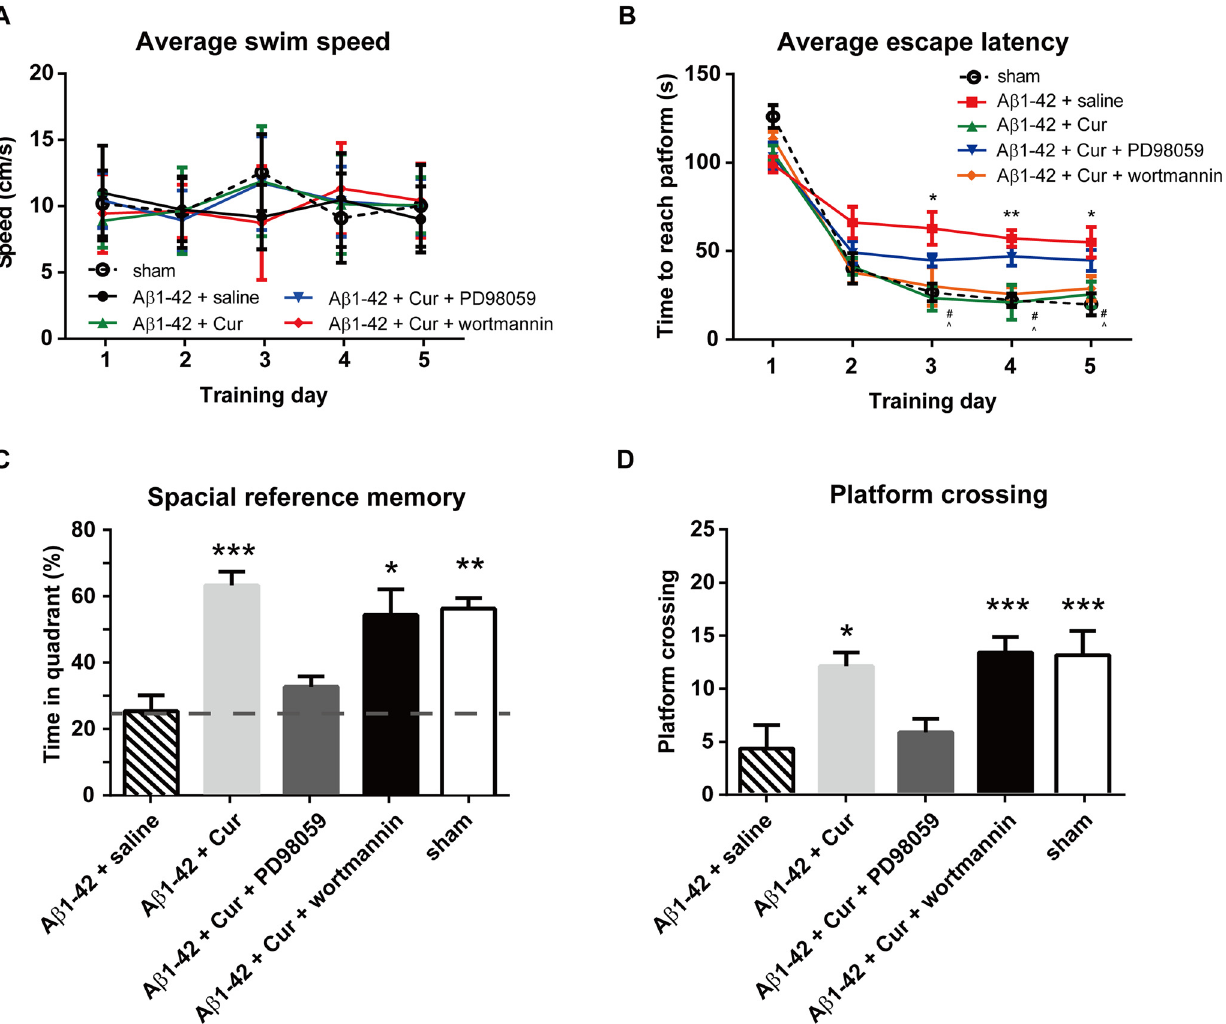
Fig 6. Effect of intra-hippocampal injections of ERK inhibitor or GSK3 activator on spatial learning function in the rat model of Alzheimer's disease. The ERK inhibitor PD98059 (20 μ M) or GSK3 activator wortmannin (100 μ M) (combined with chronic curcumin i.p. injection) was injected bilaterally into the hippocampus 30 min before the water-maze training trial. (A) Swim speed in each training trial. (B) The escape latency during the water maze training trials. (C) The time spent in the target quadrant and (D) the number of times crossing the platform in the probe task. n = 8/group. For panel B, * P < 0.05, ** P < 0.01, A β 1 – 42 + saline vs . sham control group; # P < 0.05, A β 1 – 42 + Cur vs . A β 1 – 42 + saline group; ^ P < 0.05, A β 1 – 42 + Cur + wortmannin vs . A β 1 – 42 + saline group. For other panels, * P < 0.05, ** P < 0.01, *** P < 0.0001 compared with A β 1 – 42 +